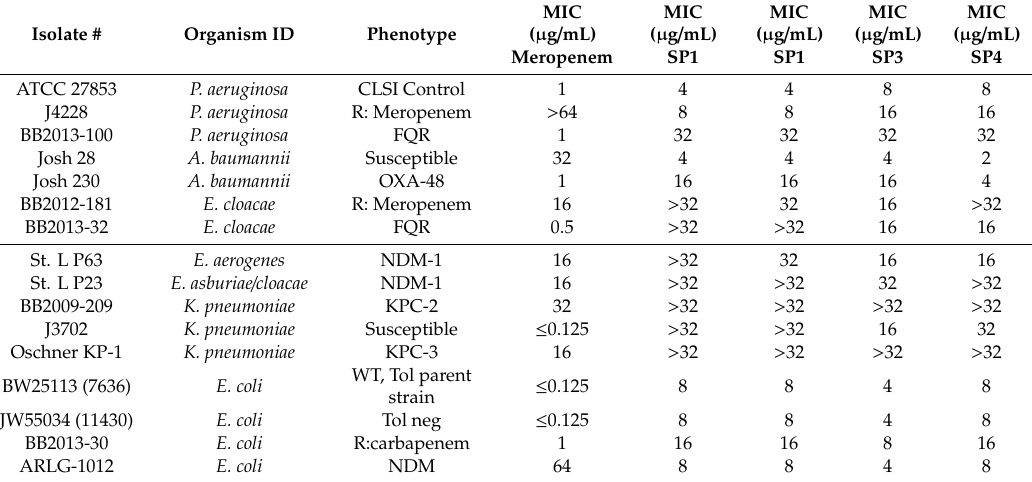
Table 4. In vitro testing of the peptides SP1–SP4 against di ff erent gram-negative bacterial strains.